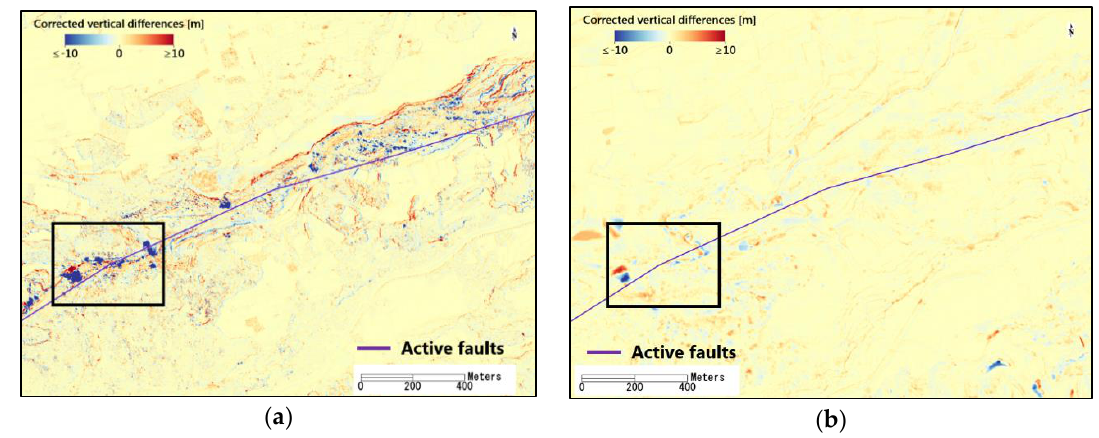
Figure 6. Vertical differences between the pre- and post-event Lidar data after removing the coseismic displacements: ( a ) Subtracting the DSM on 23 April 2016, from that on 15 April 2016; ( b ) subtracting the DTM on 8 May 2016, from that on 15 May 2006.